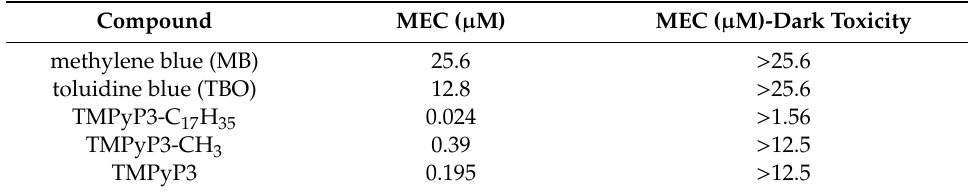
Table 3. Minimal e ff ective concentration (MEC) of methylene blue (MB), toluidine blue O (TBO), TMPyP3, TMPyP3-CH 3 and TMPyP3-C 17 H 35 on Legionella pneumophila in sterile tap water after 10